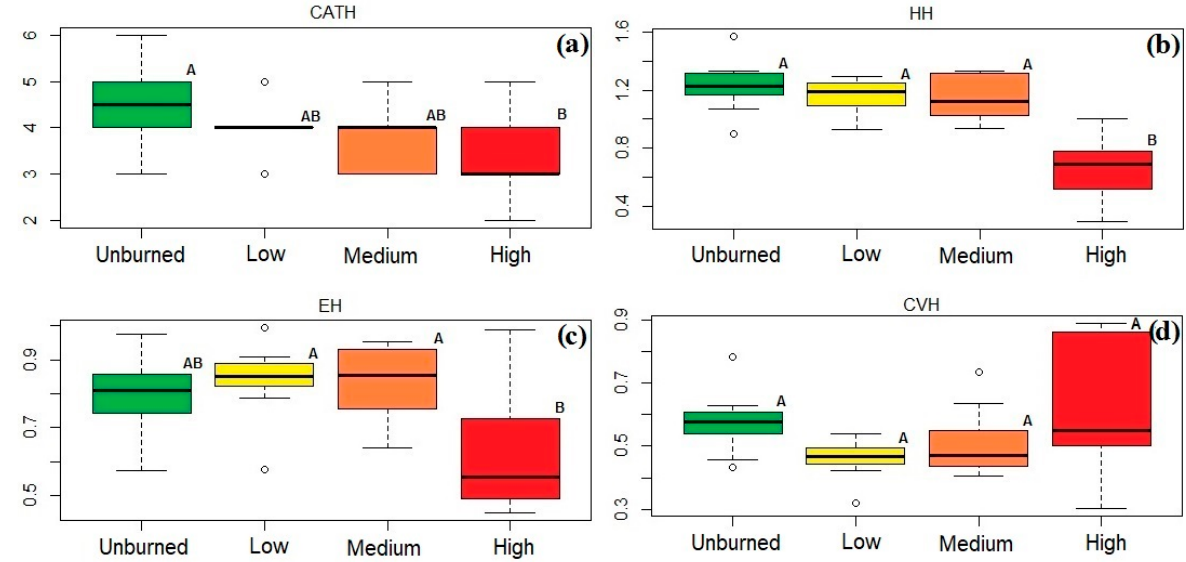
Figure 5. Tukey’s multiple comparison test for ( a ) number of height categories ( CATH ), ( b ) Shannon index ( H-H ), ( c ) Evenness Index ( E-H ), and ( d ) coefficient of variation for height ( CV-H ) by fire severity level. Different letters indicate that means were significantly different ( p ≤ 0.05); the same letters indicate non-significant differences.